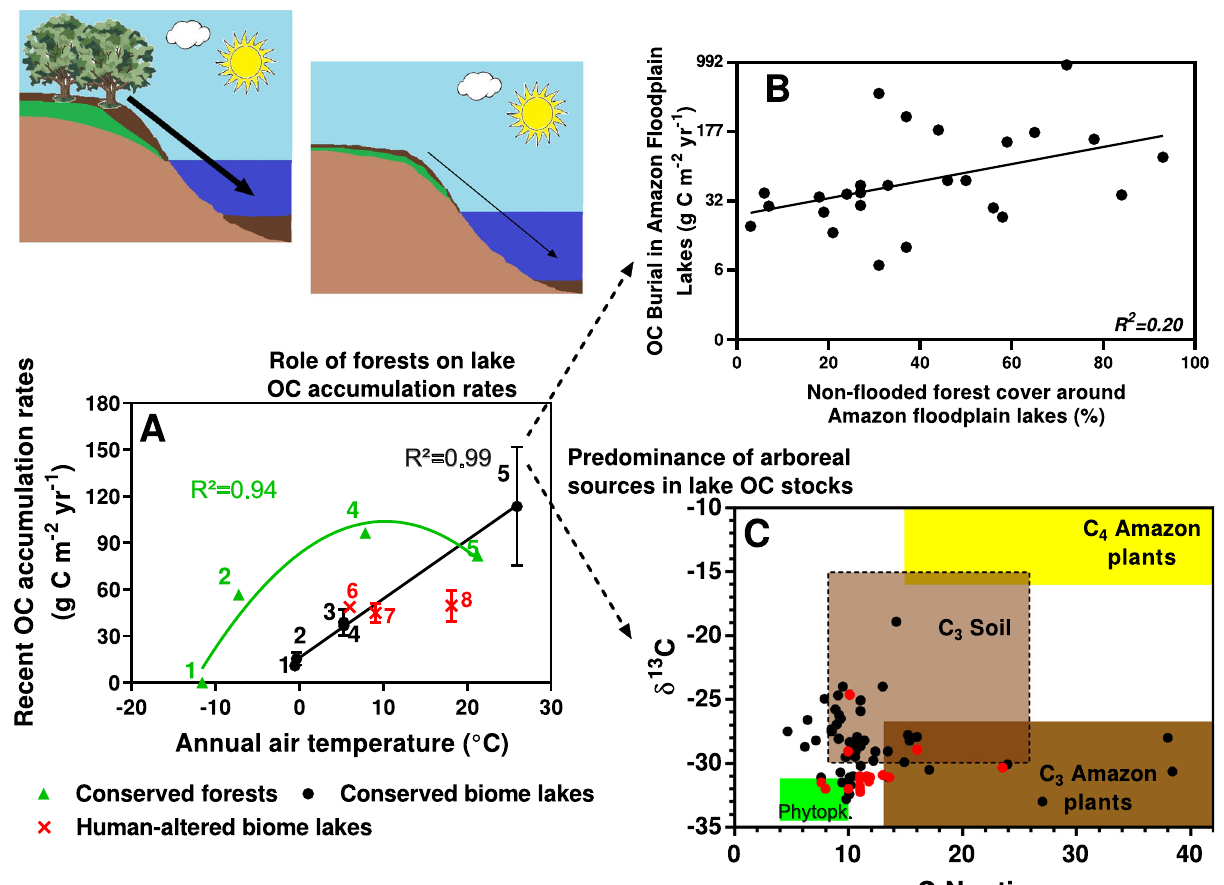
Fig. 3 The role of forests on lake OC accumulation rates with increasing temperature. Panel A shows the relationships between forest OC accumulation (green triangles), lake OC burial in natural (black circles), and human-altered (red crosses) biomes with annual air temperatures along the global gradient. The number 1 represents the subpolar and polar biomes; 2 the boreal forest; 3 temperate forest; 4 the other medium latitudes; and 5 the humid tropical forest. In turn, numbers 6, 7, and 8 represent the human-altered biomes in cold, moderate-temperature, and warm anthropic environments, respectively >15.0, 7.5 – 15.0, and <7.5 °C. The solid green line indicates the fi tted second-order polynomial model of forest